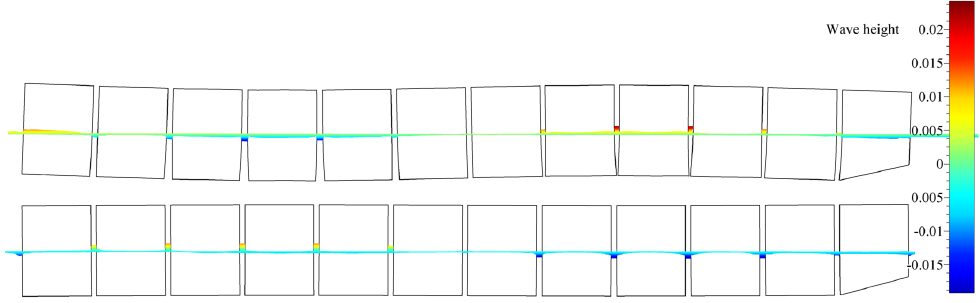
Figure 8. Profile view of free surface elevation along the barge’s length for the second mode of vertical vibration.